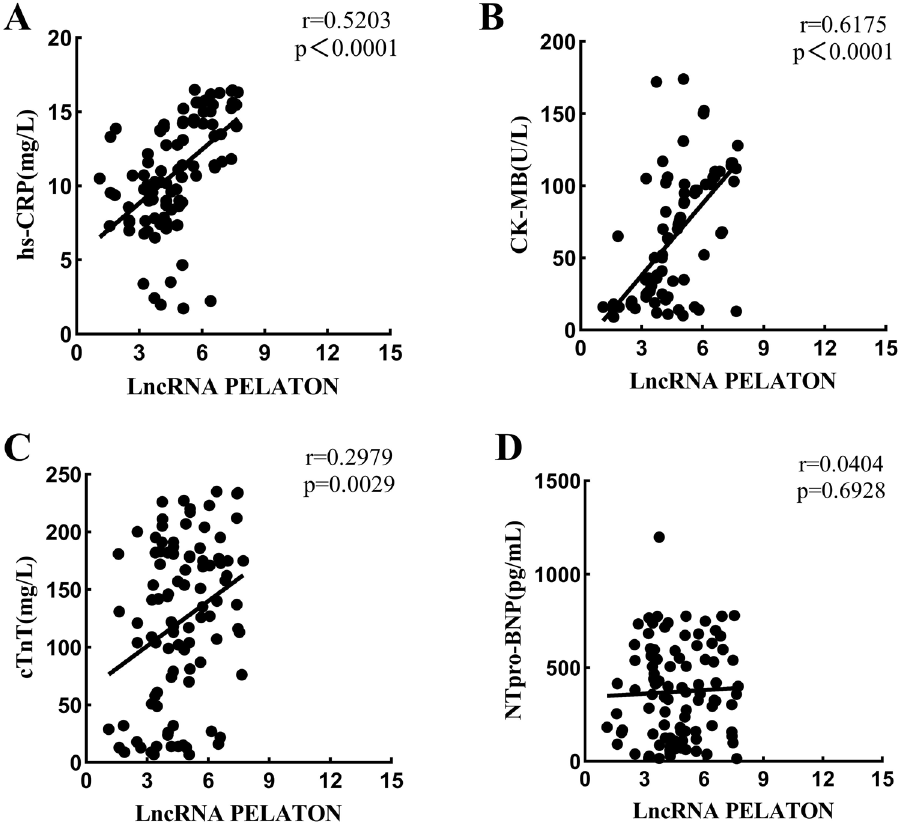
Figure 2. Correlation analysis of the expression of lncRNA PELATON with the concentration of myocardial indicators. ( A ) Correlation between lncRNA PELATON and hs-CRP; ( B ) Correlation between lncRNA PELATON and CK-MB; C. Correlation between lncRNA PELATON and cTnT; ( D ) Correlation between lncRNA PELATON and NTpro-BNP.